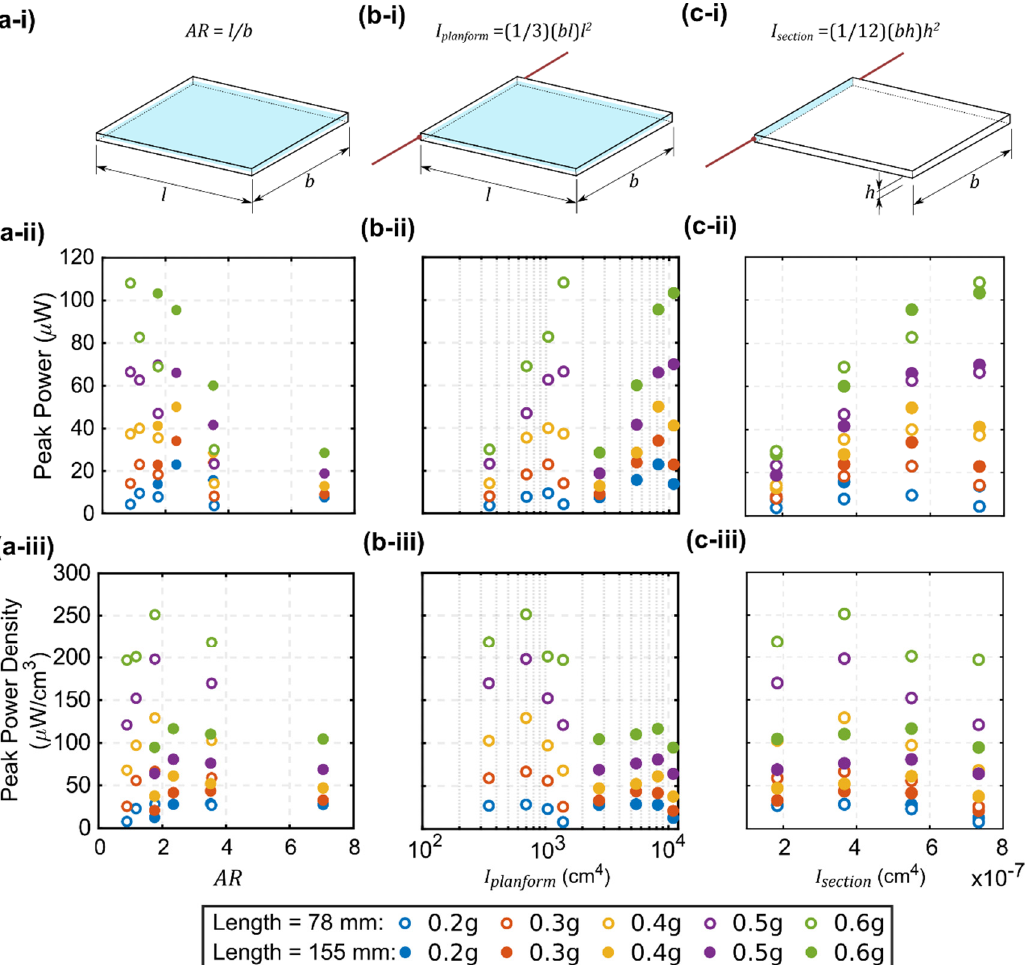
Figure 8. Variation of the peak power and the peak power density against: ( a ) aspect ratio; ( b ) and ( c ) different definitions of the second moment of area. Panels designated with ( i ) provide schematics of the different geometric characteristics considered including aspect ratio, the second moment of planform area, and the second moment of sectional area. Panels designated with ( ii ) provide peak power variations. Panels designated with ( iii ) provide peak power density variations. For simplicity, in the calculation of I section , the h value is taken as 0.1 mm of the metal shim